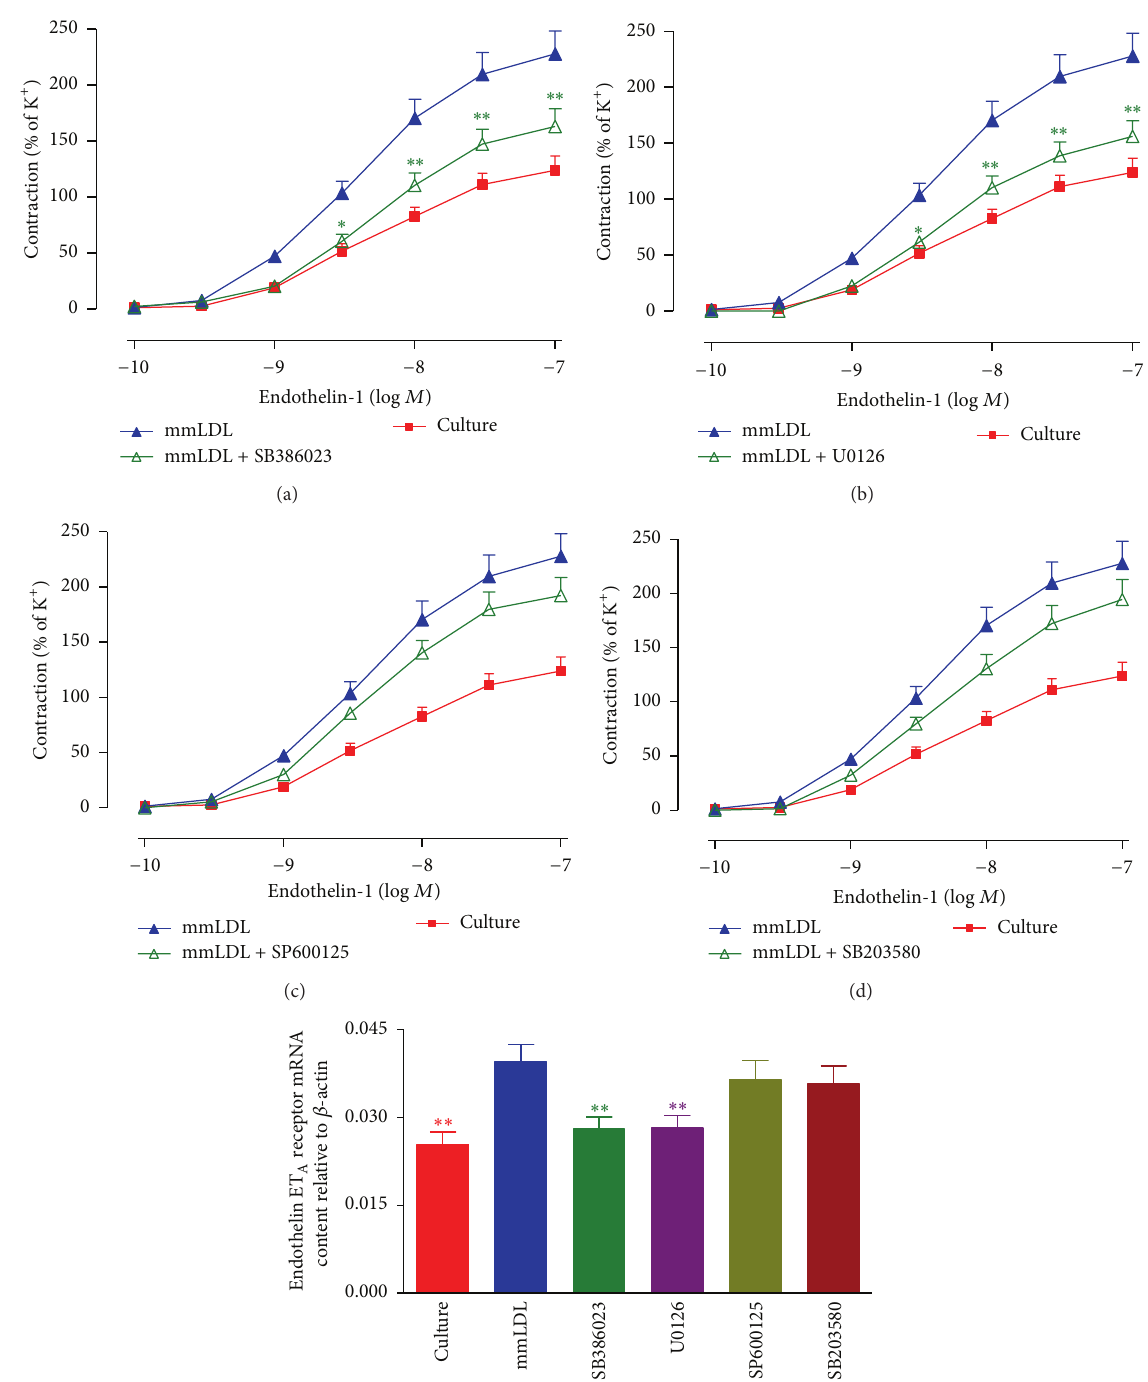
Figure 4: Effect of the MAPK pathway inhibitors on the mmLDL-induced increase in contractile function and levels of ET A receptor mRNA in the coronary artery. After rat coronary arteries were cultured for 24 h with mmLDL (10 𝜇 g/mL) in the presence of MAPK inhibitors, including the ERK1/2 inhibitors SB386023 (a), U0126 (b), the JNK inhibitor SP600125 (c), or the p38 inhibitor SB203580 (d), the ET-1- induced concentration-contraction curves were constructed ( 𝑛 = 8 coronary arteries, from that number of animals). The effects of the MAPK inhibitors on the level of ET A receptor mRNA are shown ((e) 𝑛 = 5 -6 coronary arteries, from that number of animals). The data are presented as the mean ± SEM. ∗ 𝑃 < 0.05 , ∗∗ 𝑃 < 0.01 versus